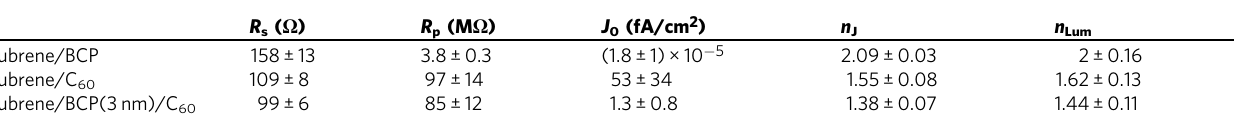
Table 1 Summary of the 1-diode-equivalent circuit model